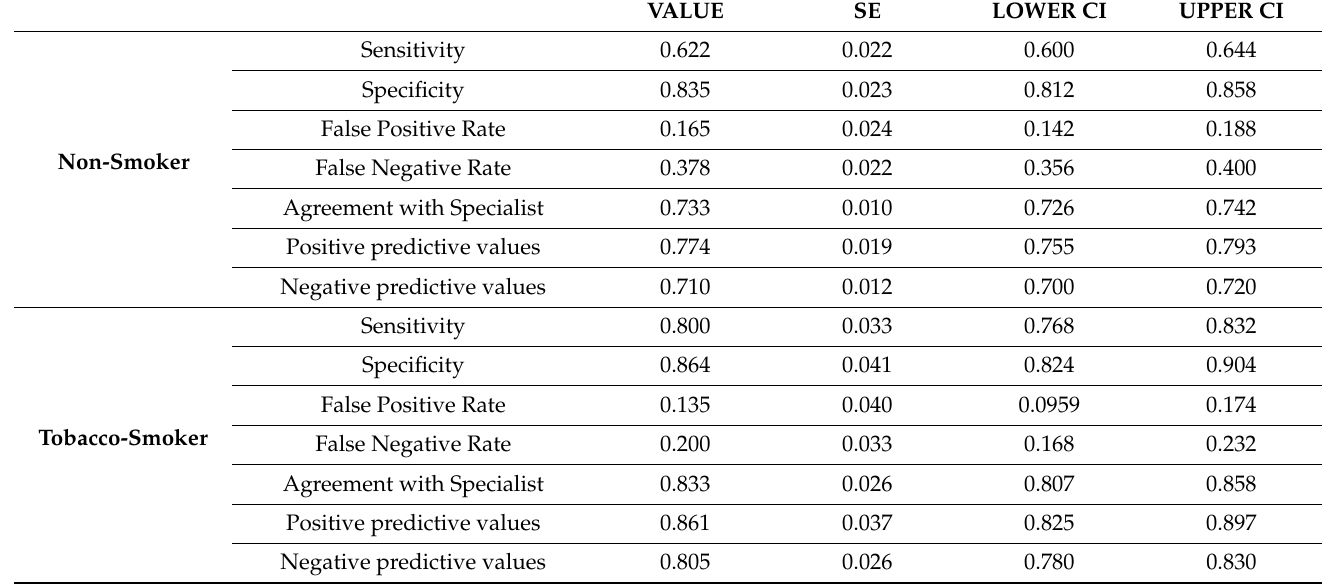
Table 3. Screening performance algorithm vs. specialist in non-tobacco smoker vs tobacco